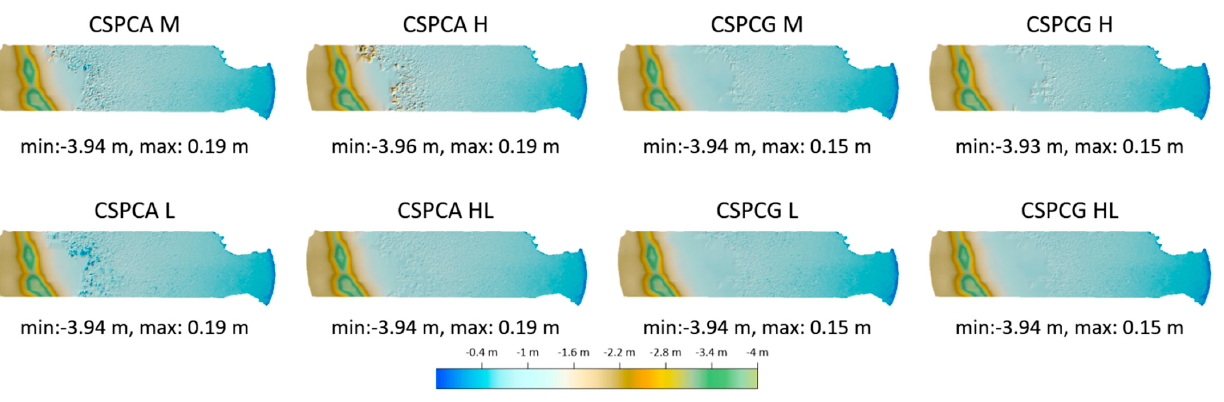
Figure 19. Models obtained by triangulation.